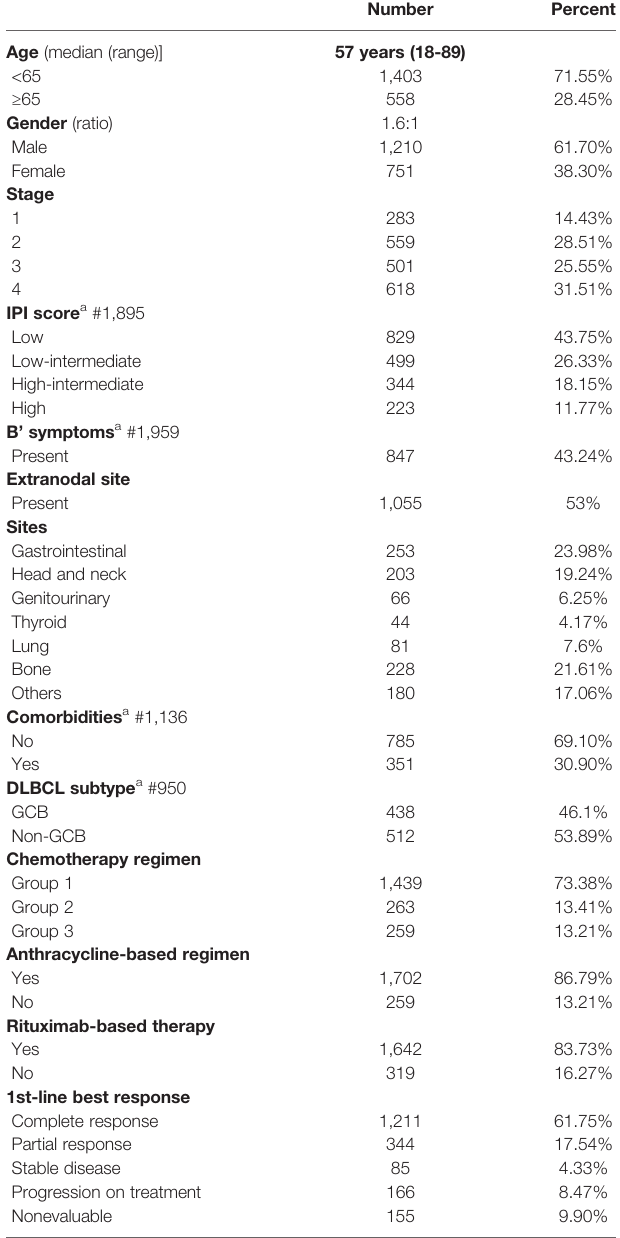
TABLE 1 | Clinical characteristics at presentation, treatment, and response of 1,961 DLBCL